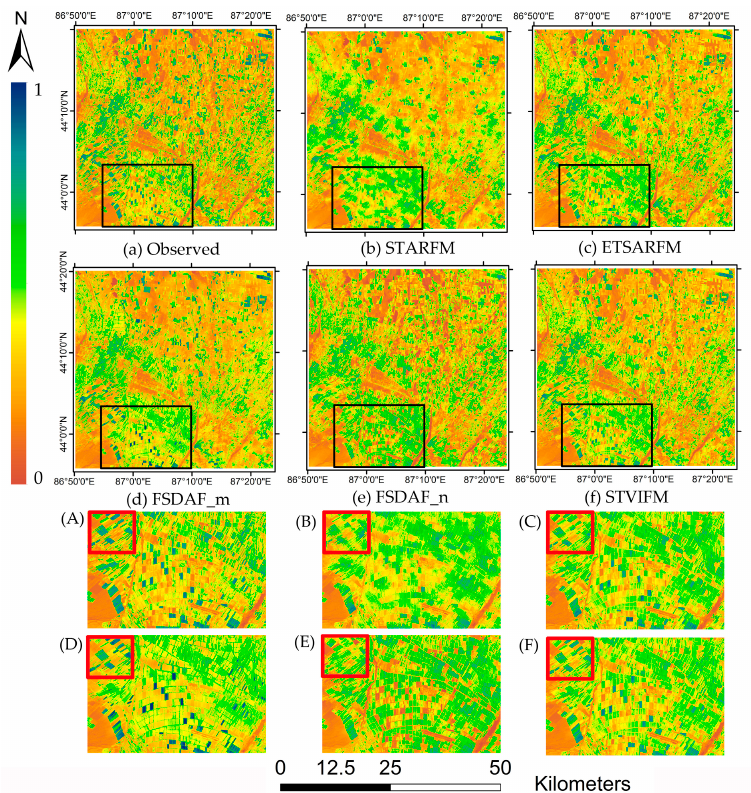
Figure 13. Comparison of the observed Landsat image ( a ); and the synthetic images based on: STARFM ( b ); ESTARFM ( c ); FSDAF_m ( d ); FSDAF_n ( e ); and STVIFM ( f ) in Xinjiang, China. ( A – F ) Zoom-in images shown in the black boxes on the original NDVI and the all the results generated by the four methods. Red boxes show the senescent fields.